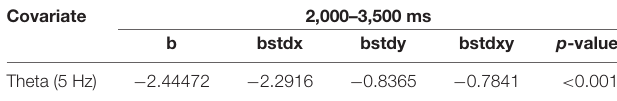
TABLE 1 | Analytic results of electroencephalogram (EEG) power spectra over time in the frontal midline cluster, using a logistic regression model (5 Hz).